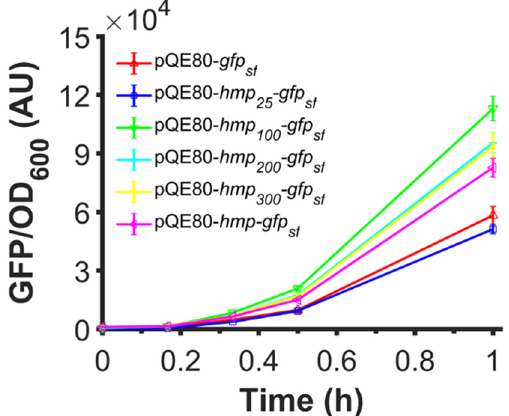
Figure 9. Fusions of truncated versions of Hmp that are as long as 100 AA also increase expression. Shown are GFP fluorescence normalized by OD 600 after subtraction of the background signal (wild- type harboring pQE80L) of wild-type harboring pQE80-P T5 - gfp sf (pXW09) , pQE80-P T5 - hmp 25 -gfp sf (pXW16) , pQE80-P T5 - hmp 100 -gfp sf (pXW17) , pQE80-P T5 - hmp 200 -gfp sf (pXW18) , pQE80-P T5 - hmp 300 - gfp sf (pXW19) , pQE80-P T5 - hmp-gfp sf (pXW08) after induction of 1 mM IPTG at time 0. Corresponding OD 600 measurements and data of uninduced samples can be found in Figure S5. Data are the means of at least three independent replicates, and error bars represent the standard errors of the